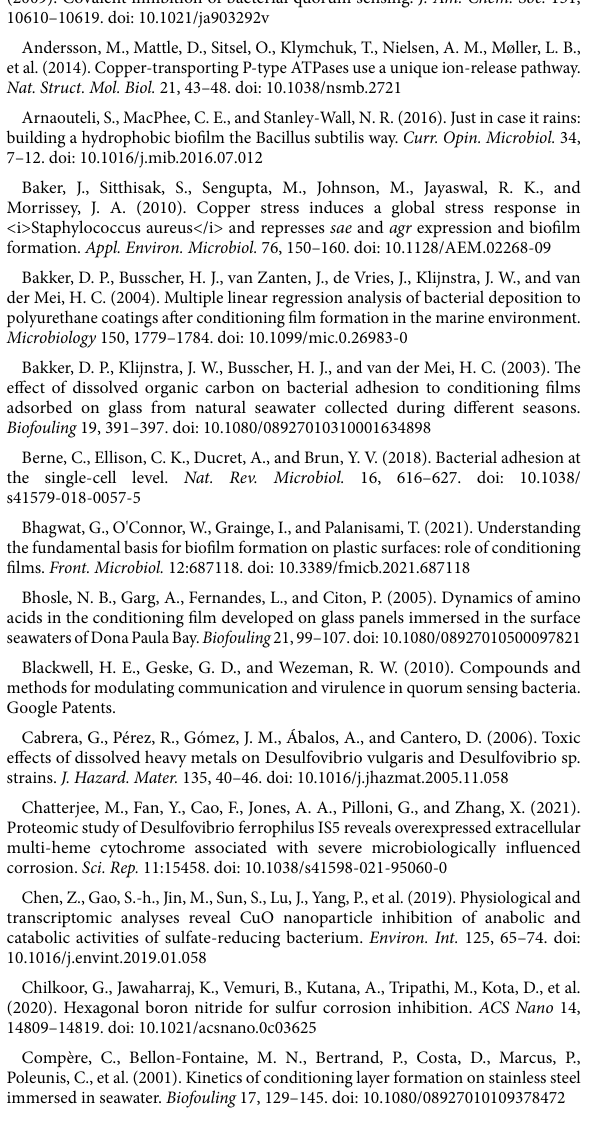
SUPPLEMENTARY FIGURE 1 Overview of molecular interactions and networking among all essential genes involved in the autoinducer release in Oleidesulfovibrio alaskensis